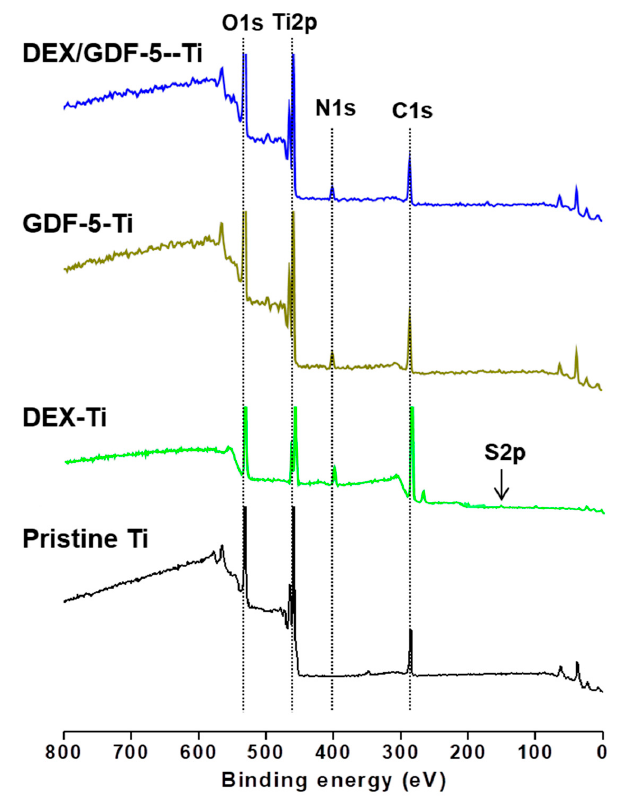
Figure 2. X-ray photoelectron spectroscopy (XPS) spectra of pristine Ti, dexamethasone (DEX)–Ti, growth and differentiation factor-5 (GDF-5)–Ti and DEX/GDF-5–Ti disc samples, as monitored from 100 to 800 eV.